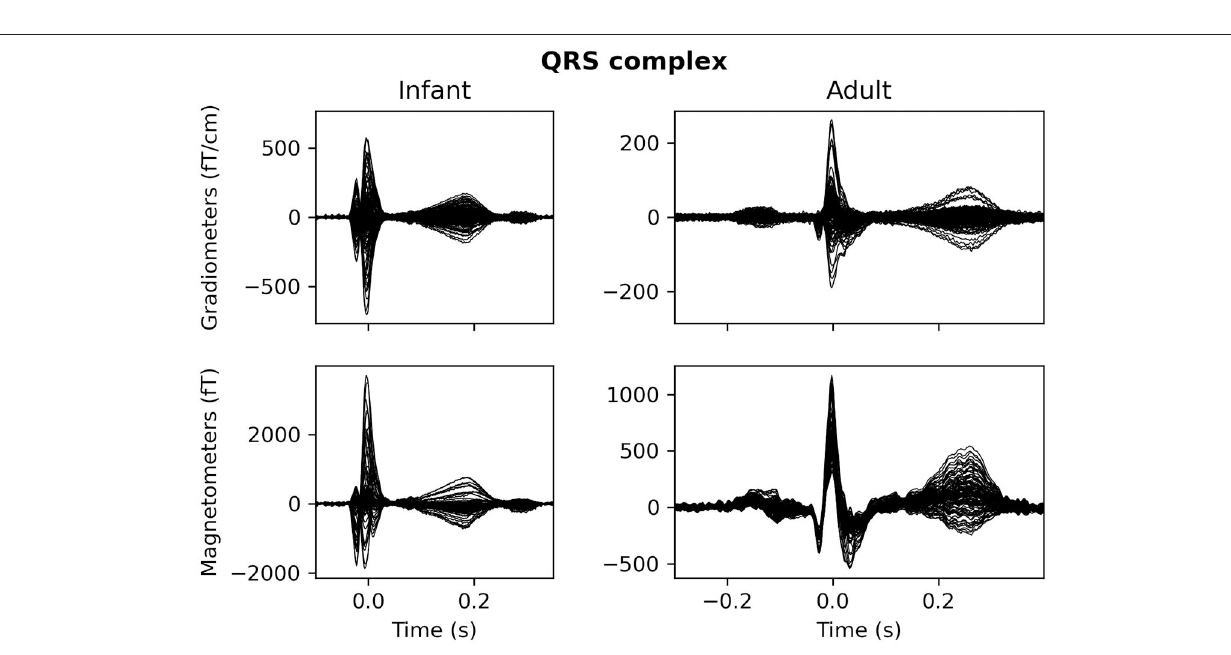
FIGURE 4 | The average QRS complex from exemplar infant (left) and adult (right) MEG